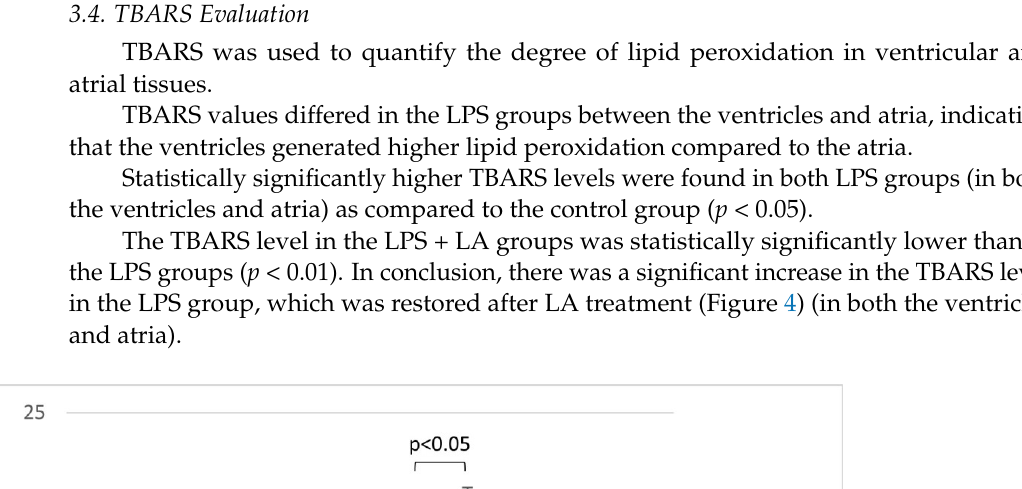
Figure 3. Effect of LA, LPS, and LPS + LA on SOD activities in ventricular and atrial homogenates. Results are shown as mean ± S.E.M. n = 8. * p < 0.05 vs. control, LA, LPS + LA; # p < 0.01 vs. control. LA—alpha lipoic acid, LPS—lipopolysaccharide.